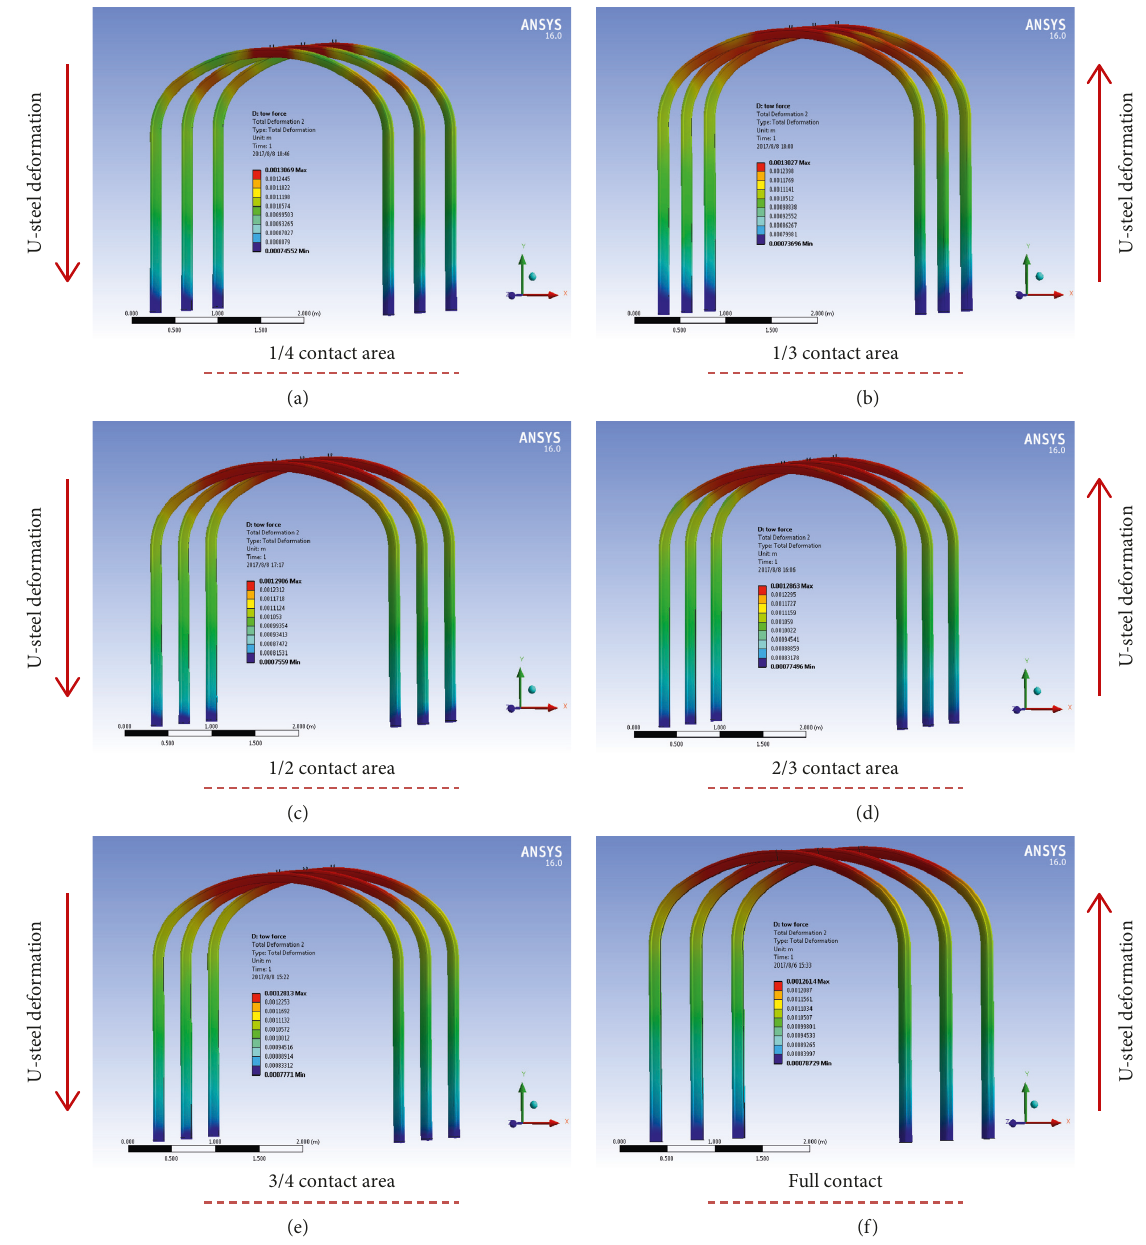
Figure 9: Total deformation of U-shaped steel with the contact area ratios of (a) 1/4, (b) 1/3, (c) 1/2, (d) 2/3, (e) 3/4, and (f) 1/1. The maximum deformation values were 1.3069mm, 1.3027mm, 1.2906mm, 1.2863mm, 1.2813mm, and 1.2614mm,